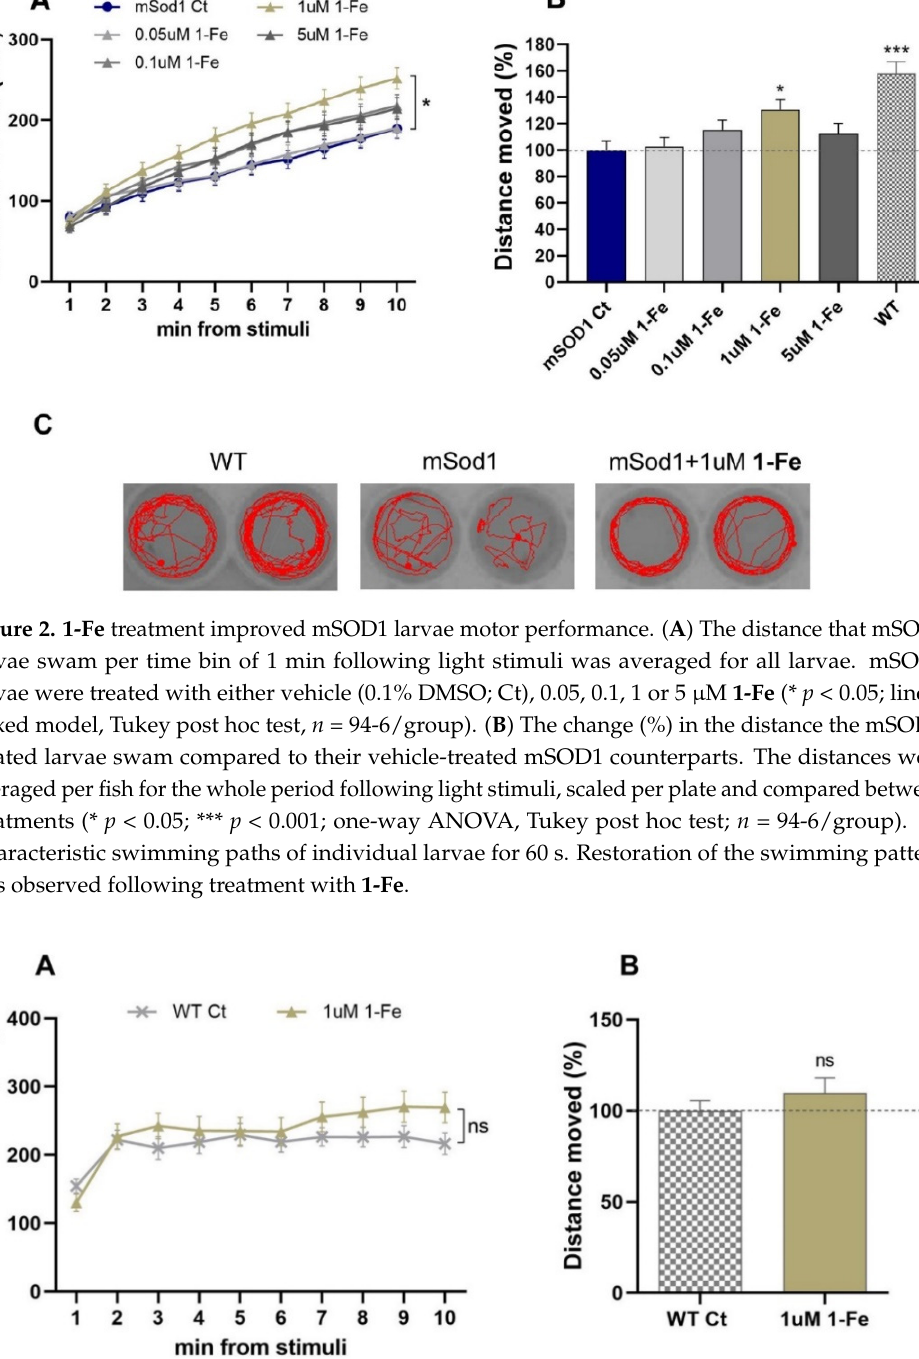
Figure 3. 1-Fe treatment did not affect motor activity of WT larvae. ( A ) The distance vehicle-treated (0.1% DMSO; Ct) or 1 µ M 1-Fe -treated WT larvae swam, per time bin of 1 min following light stimuli was averaged (ns = non-significant; linear mixed effect model, n = 48/group). ( B ) The change (%) in the distance the WT-treated larvae swam compared to their vehicle-treated WT counterparts. The distances swam were averaged per larva for the whole 10 min following light stimuli, scaled per plate and compared between treatments (ns = non-significant; linear mixed effect model, n =